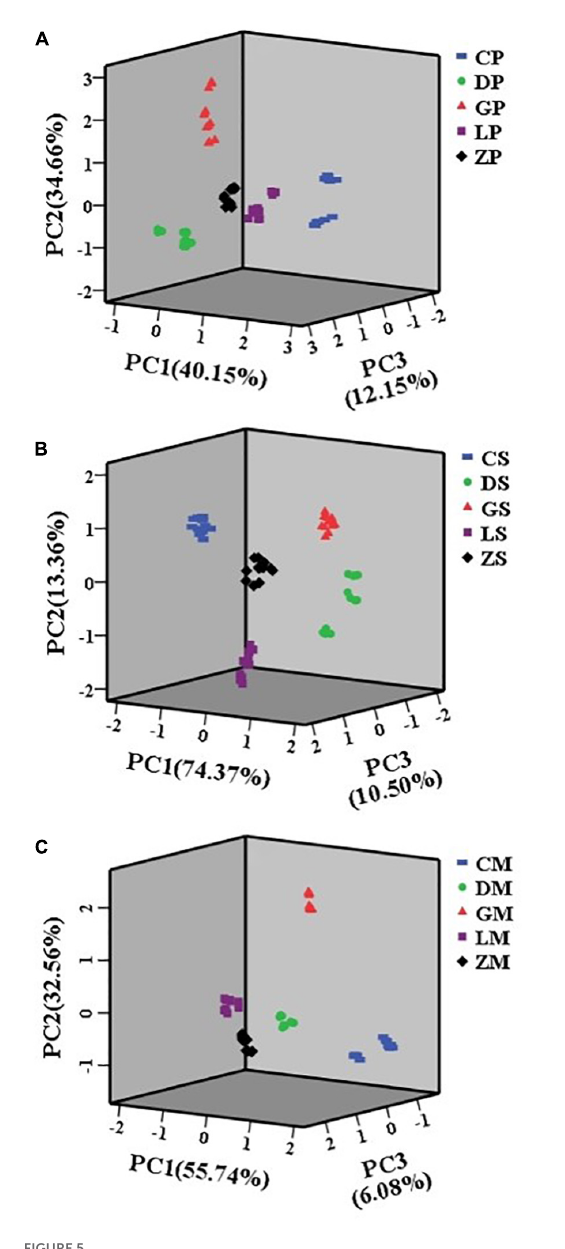
FIGURE4 Principal component analysis (PCA) plots of seasoning powder (A) , seasoning mixture sauce (B) , and the mixture of powder and sauce (C) using e-tongue.